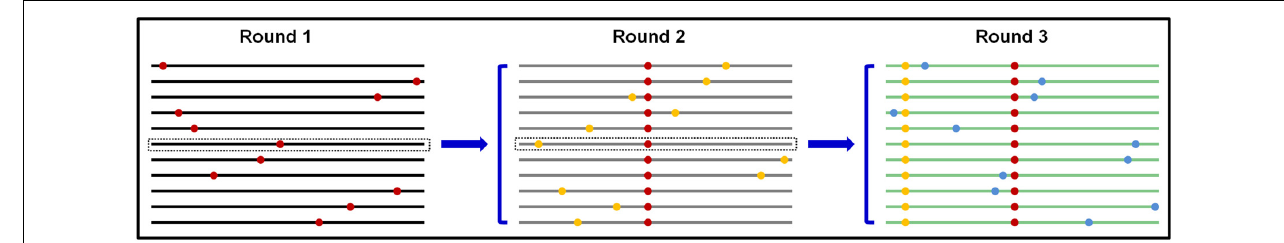
FIGURE 3 | Predicted scenario if progeny TCV genomes are permitted to repeat replication in the same cells. Round 1 replication produces progeny genomes that contain one random error per genome on average. Using the middle genome as an example, permitting it to proceed to round 2 would proliferate the round 1 error (red dot) into more progenies, and compound it with additional random errors (yellow dots). Repetition of this process would result in genomes with too many errors that are predicted to be less